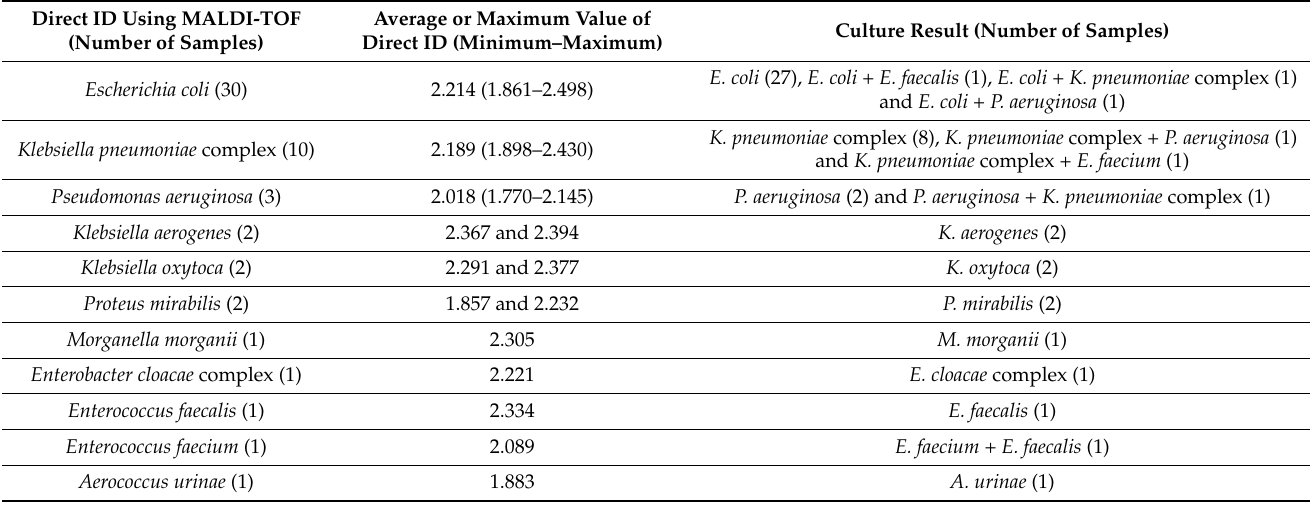
Table 1. Summary of 54 positive culture samples with reliable direct